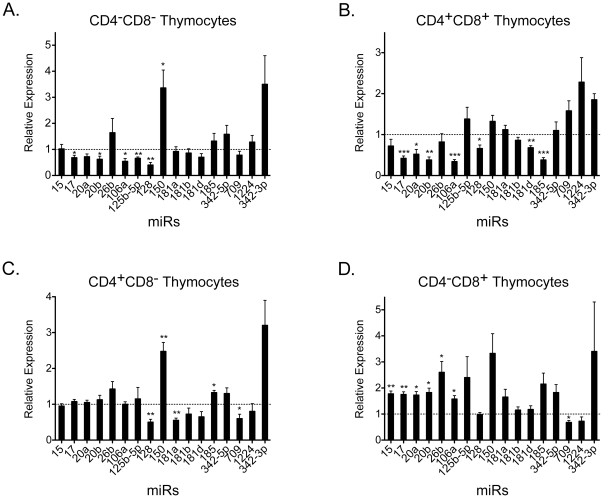
Stress responsive thymic miRs are differentially regulated in thymocyte subsets.Thymocytes from PBS and LPS injected mice (72 h) were sorted into A) CD4−CD8− (DN), B) CD4+CD8+ (DP), C) CD4+CD8− (CD4 SP), and D) CD4−CD8+ (CD8 SP) subsets using high speed cell sorting. RNA was isolated from the sorted subpopulations. Real-time microRNA RT-PCR was used to detect the levels of the indicated miRs in various subsets. The vertical line on the figure indicates the control (PBS) threshold set at 1. Data represent the averaged fold changes in miR expression levels of PBS- versus LPS-treated samples calculated by ΔΔCT normalized to the endogenous U6 levels, of 4 independent experiments performed in triplicate (*p<0.05, **p<0.01, *** p<0.001, versus the threshold; one sample Student t-test).